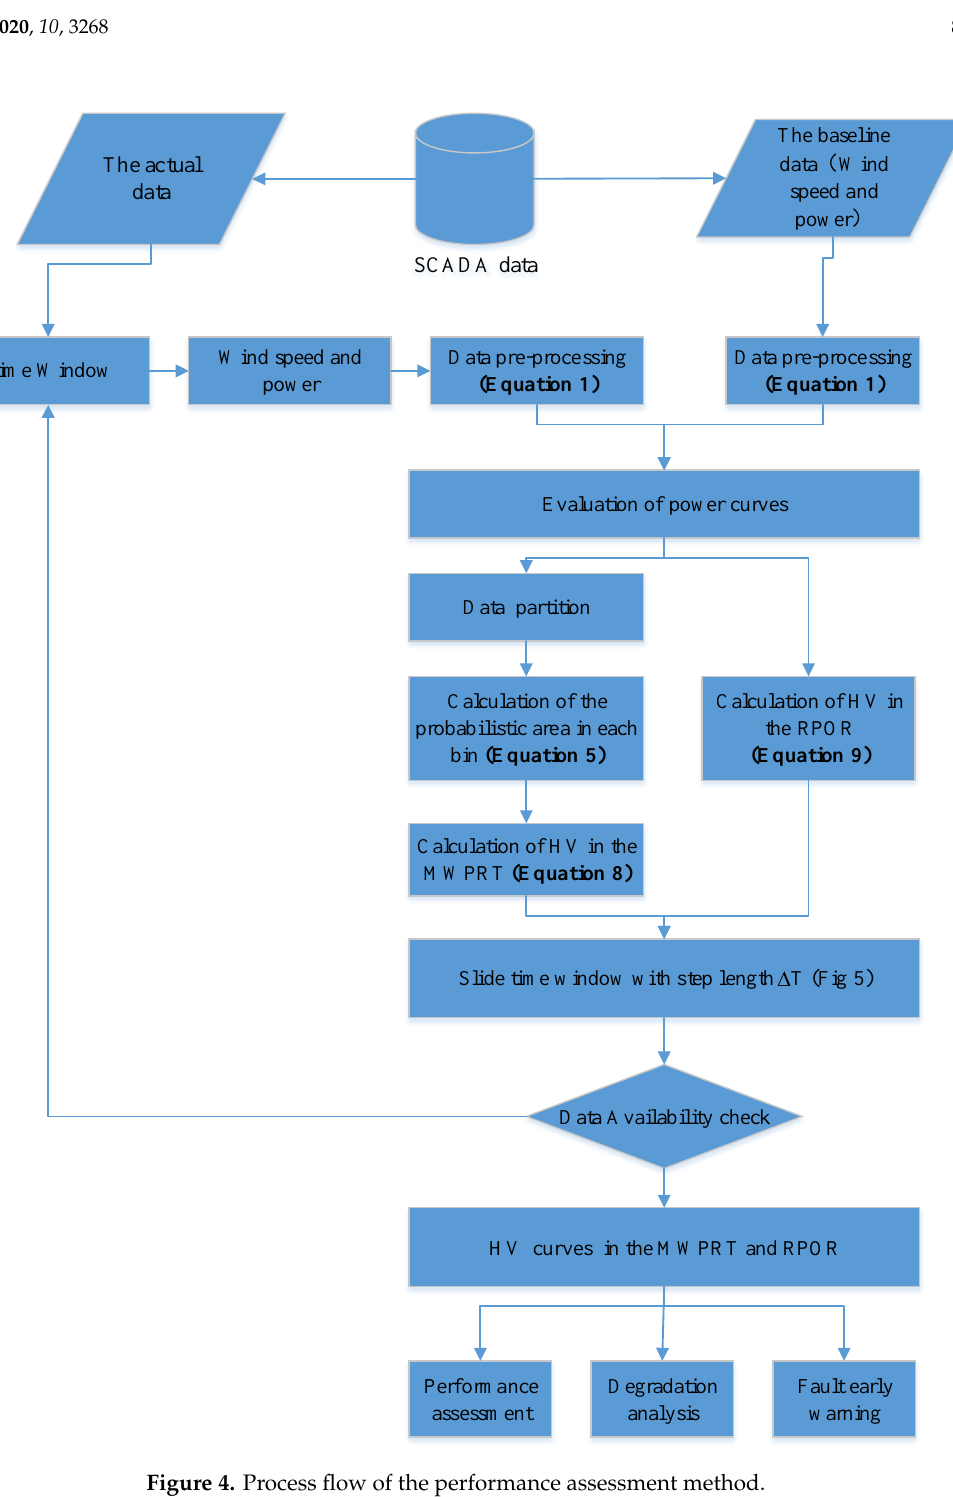
Figure 4. Process flow of the performance assessment method.